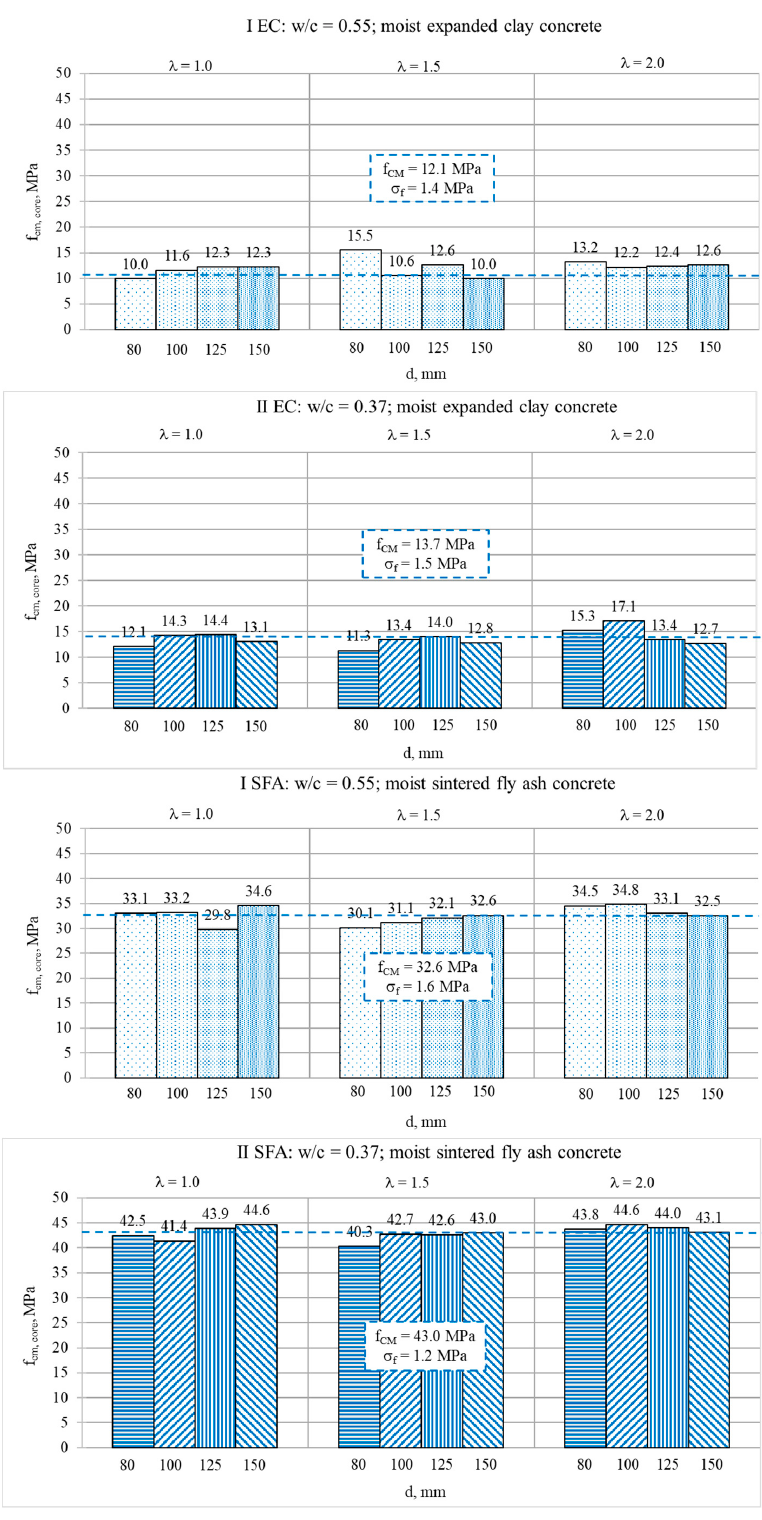
Figure 5. Mean values of compressive strength determined for moist cored specimens of various diameters d and slenderness λ